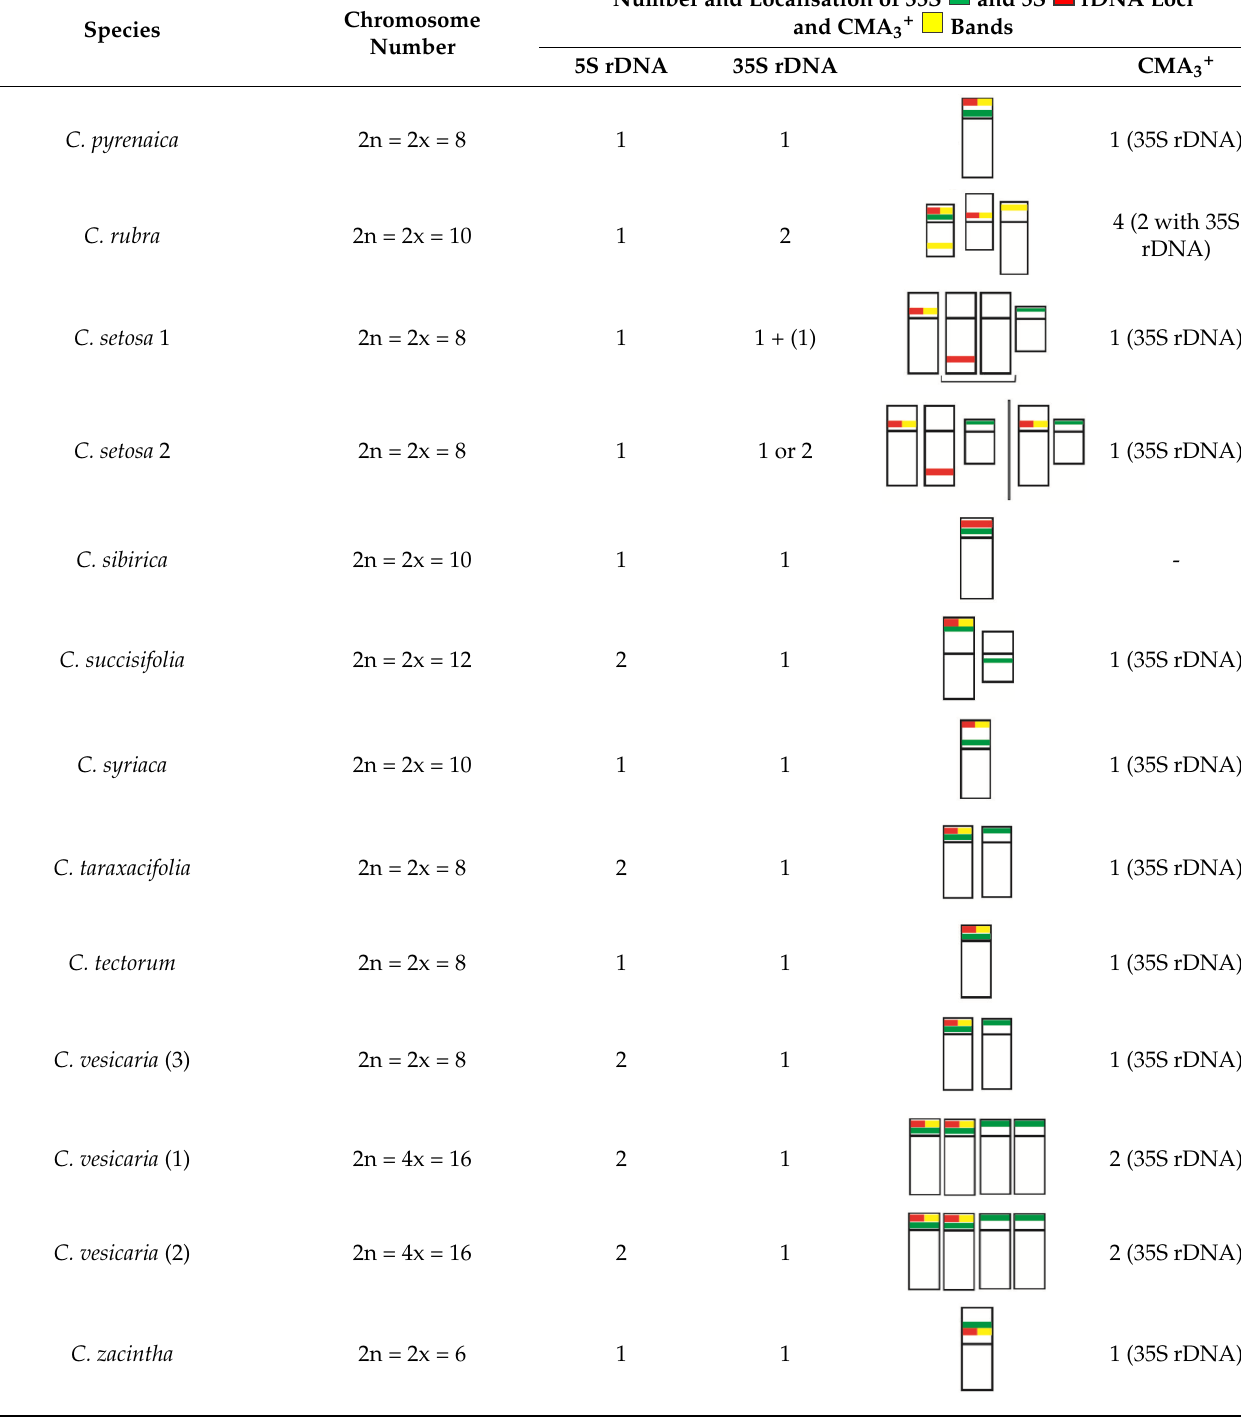
Table 1. The number and localisation of the 35S and 5S rDNA loci and CMA 3+ bands in Crepis .